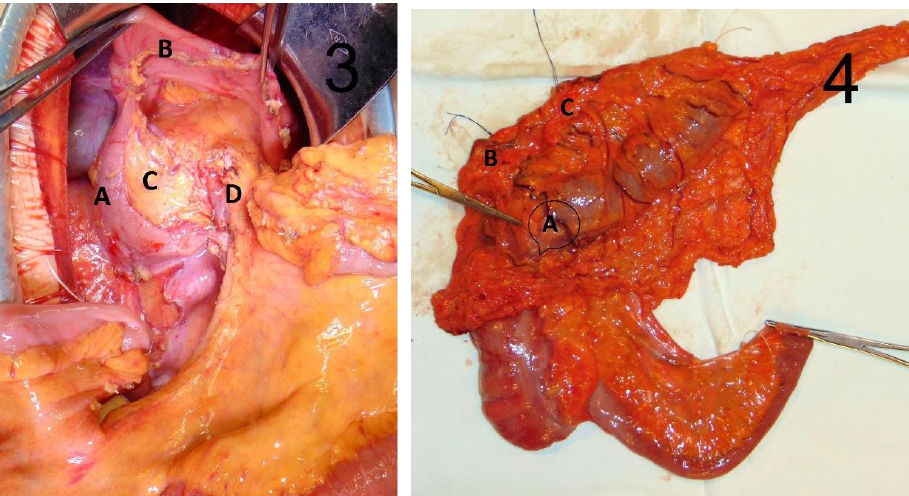
Figure 2. Intraoperative aspects. ( 1 ) Resection line of the GCL: A — tumor location in proximal transverse colon; B — stomach; C — No 206 infrapyloric LN; D — No 204 gastroepiploic LN. ( 2 ) A — duodenum; B — stomach; C — pancreas; D — middle colic vein; E — middle colic artery. ( 3 ) A — duodenum; B — stomach; C — pancreas; D — superior mesenteric vein. ( 4 ) Fresh specimen with GCL. A — tumor location; B — infrapyloric LN marked in blue line; C — gastroepiploic vessels and lymph nodes marked by blue line.